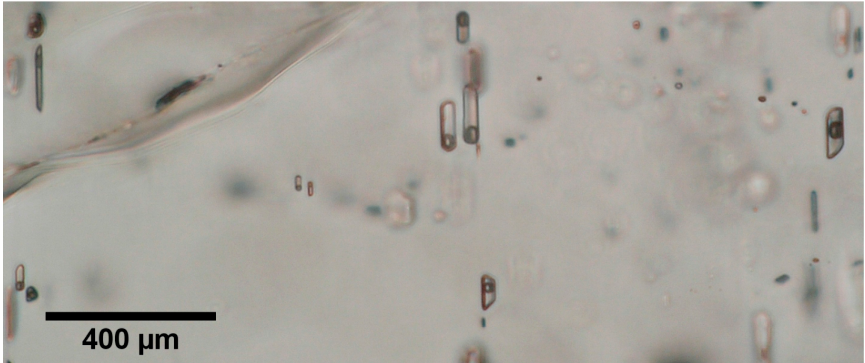
Figure 8. Photomicrograph of an assemblage of primary two-phase fluid inclusions occurring within growth zones in beryl (Figure 2). The fluid inclusions are oriented with their long axes parallel to the c-axis of the host crystal, as is typical of primary fluid inclusions in emerald [7,25]. Photomicrograph taken in plane polarised light.